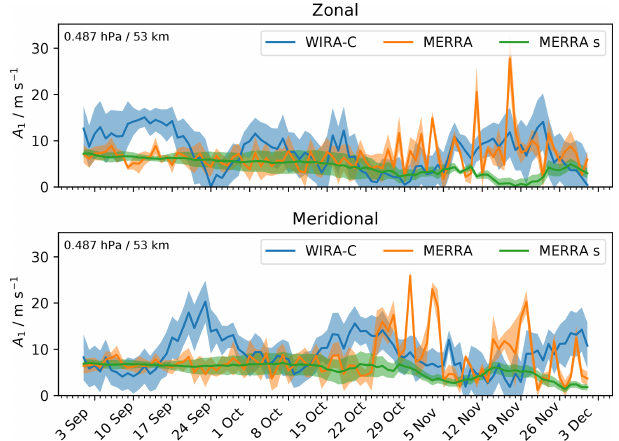
Figure 11. Time series of zonal and meridional diurnal tide am- plitudes during the arctic campaign for measurements (WIRA- C), MERRA-2 reanalysis (MERRA) and reanalysis smoothed (MERRA s) at an altitude level of 53km with corresponding errors of the model fit as shaded